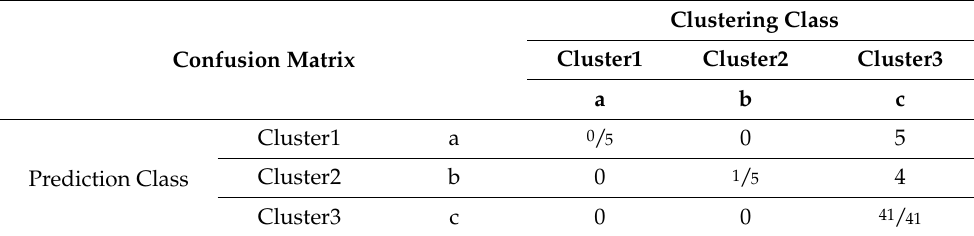
Table 10. Random forest classification validation for K-means